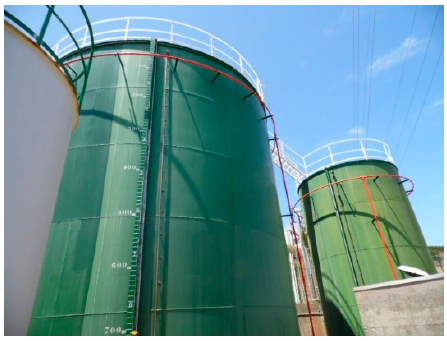
Figure 4. Fuel storage tanks.